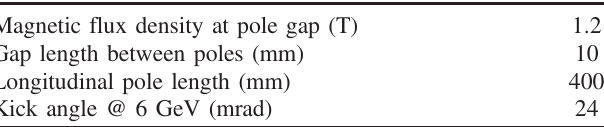
TABLE I. Main parameters of dc septum magnet. Magnetic flux density at pole gap (T) 1.2 Gap length between poles (mm) 10 Longitudinal pole length (mm) 400 Kick angle @ 6 GeV (mrad)